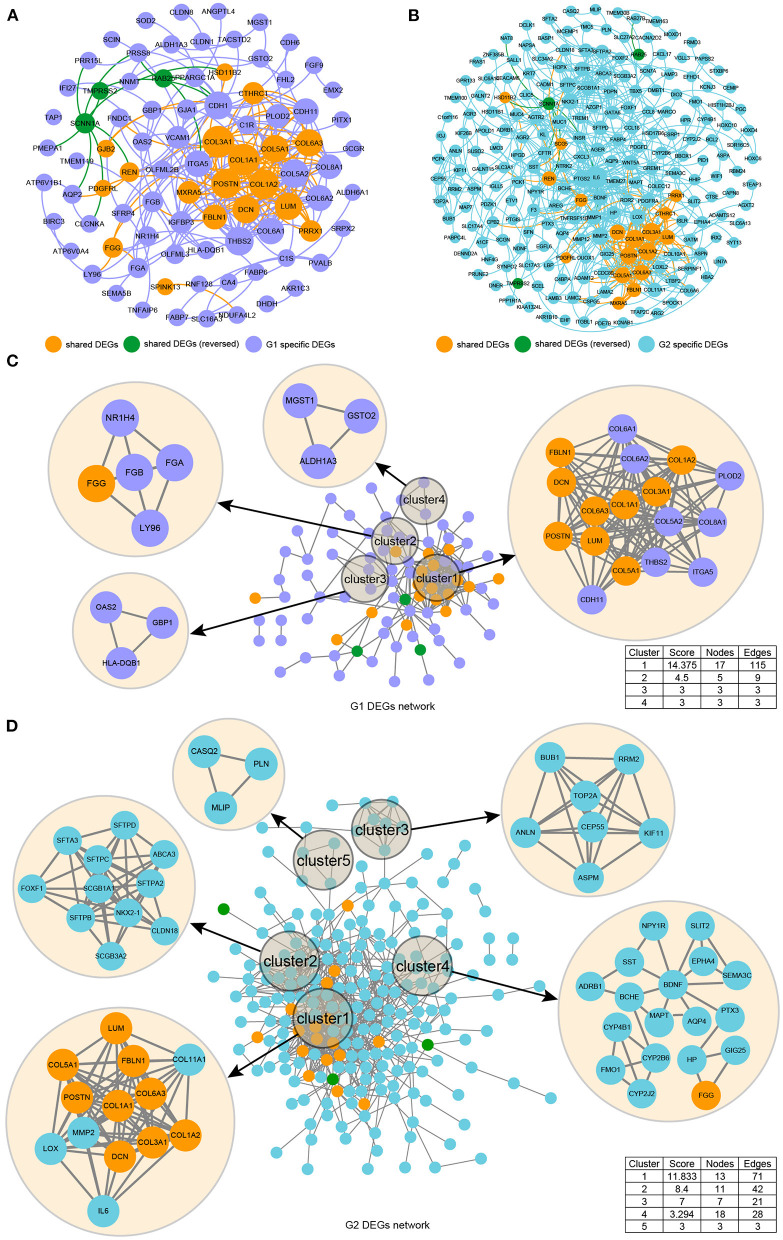
Illustration of the protein networks of DEGs from the GSE105261 (G1) and GSE85258 (G2) datasets. The spatial distribution characteristics of the PPI network model of G1 (A) and G2 (B) based on a macro perspective were constructed by the “Fruchterman–Reingold” layout in the Gephi software. The spatial distribution characteristics of the PPI network model of G1 (C) and G2 (D) based on independent perspectives were constructed by the MCODE plugin of Cytoscape software.